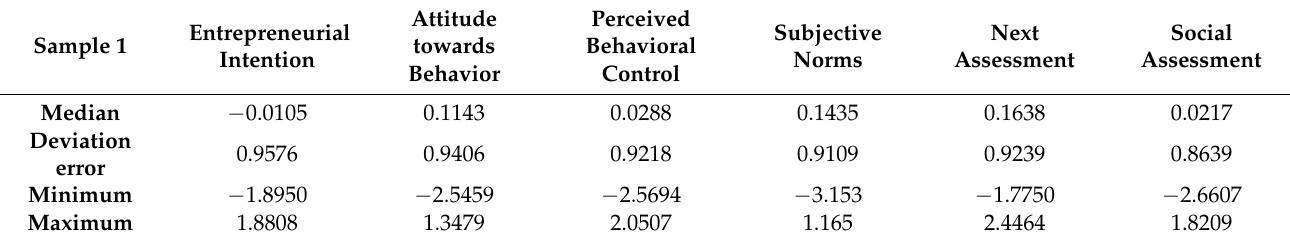
Table 3. Descriptive statistics of the scores obtained in sample